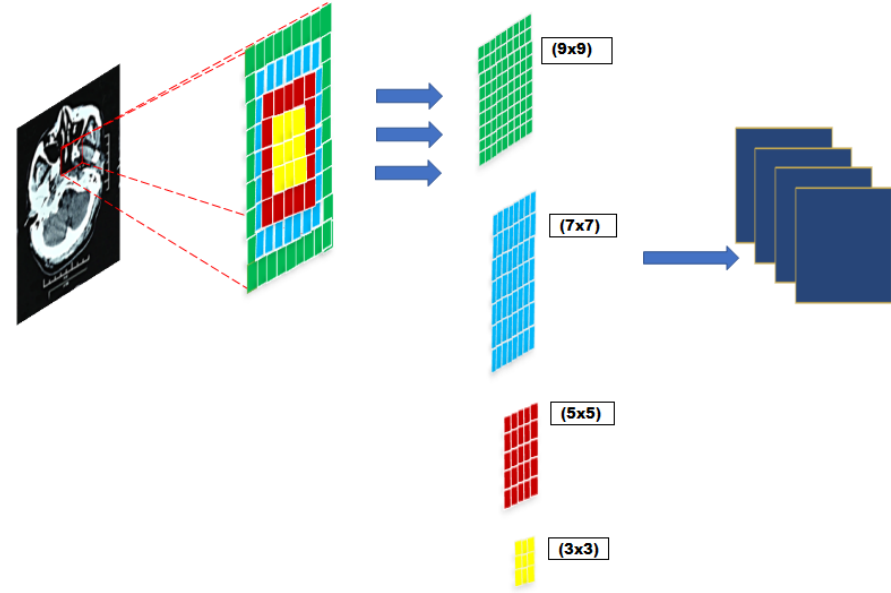
Figure 3. Feature extraction using different patch sizes.